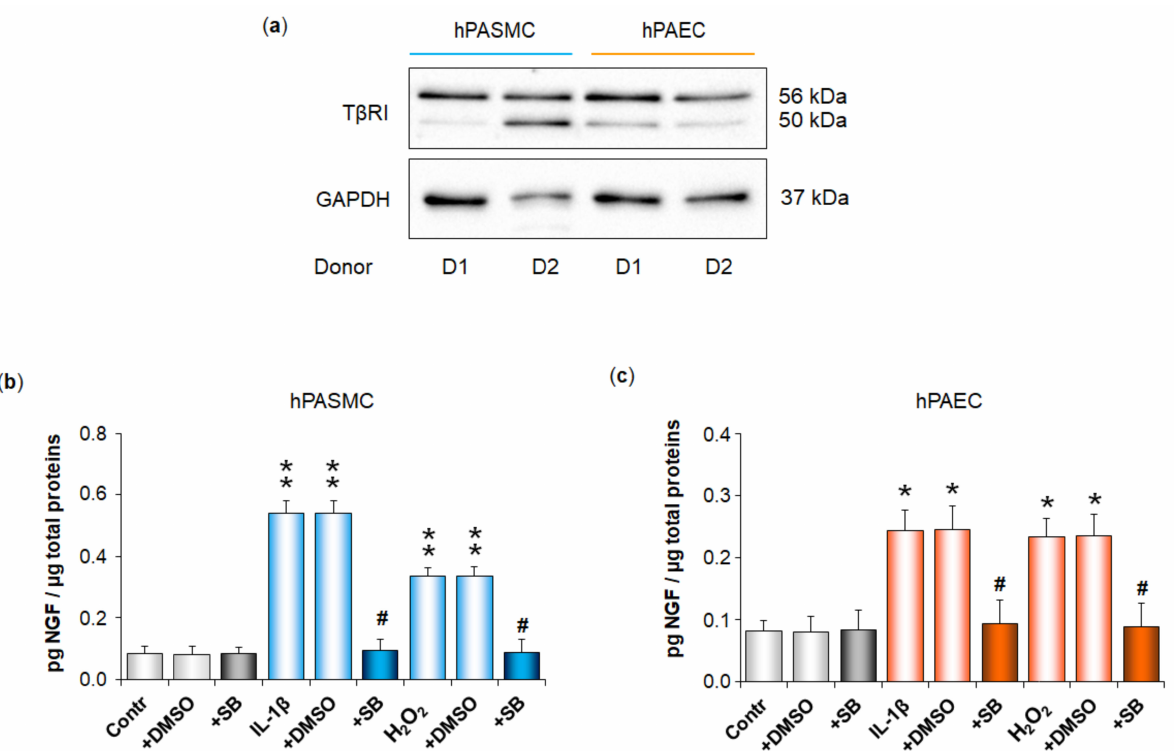
Figure 5. Expression of the TGF- β 1 receptor T β RI in human pulmonary arterial cells and its role in IL- 1 β - or H 2 O 2 -induced increase in NGF secretion by these cells. ( a ) Basal protein expression of T β RI was assessed by Western blotting analysis in human pulmonary arterial smooth muscle cells (hPASMC) or human pulmonary arterial endothelial cells (hPAEC). Immunoblots presented on cells from two control donors (D1 and D2) are representative of experiments conducted on pulmonary arterial cells from n = 3–5 control donors, showing identical results. Results are normalized to glyceraldehyde-3- phosphate dehydrogenase (GAPDH). ( b , c ) NGF secretion by ( b ) hPASMC or ( c ) hPAEC was assessed in the absence or presence of interleukin-1 β (IL-1 β , 10 ng/mL, 24 h) or hydrogen peroxide (H 2 O 2 , 10 µ M, 24 h). Involvement of T β RI was investigated through pre-treatment (30 min) of ( b ) hPASMC or ( c ) hPAEC with SB525334, an inhibitor of T β RI receptor kinase activity (SB, 1 µ M). The effect of this inhibitor on NGF basal secretion was investigated. In addition, the effects of dimethyl sulfoxide (DMSO), the vehicle of the SB compound, on NGF basal and induced secretions were evaluated. NGF secretion was determined by ELISA (results expressed as pg NGF/ µ g total proteins). The data represent the means ± SEM of n = 5 independent experiments performed in triplicate on cells from three to five donors. * p < 0.05 and ** p < 0.01 versus untreated control cells (Contr). # p < 0.05 versus cells treated with IL-1 β or H 2 O 2